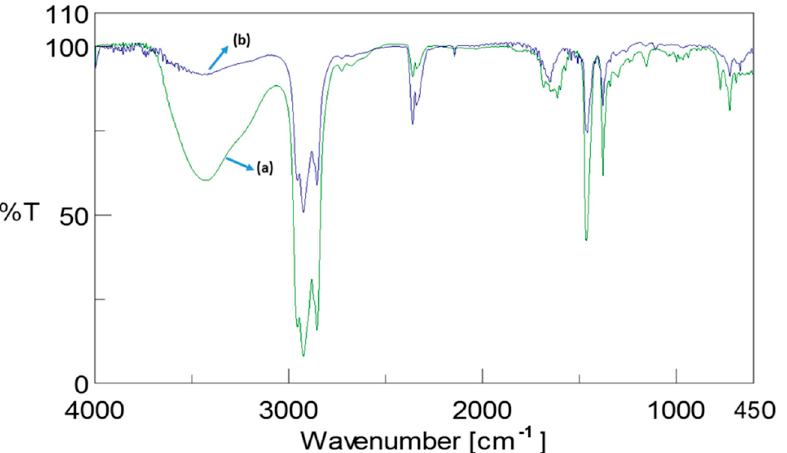
Figure 3. The overlay of FT-IR spectra of ( a ) root extract of W.sominfera and ( b ) as-prepared ZnONPs depicting the involvement of various functional groups in their formation.